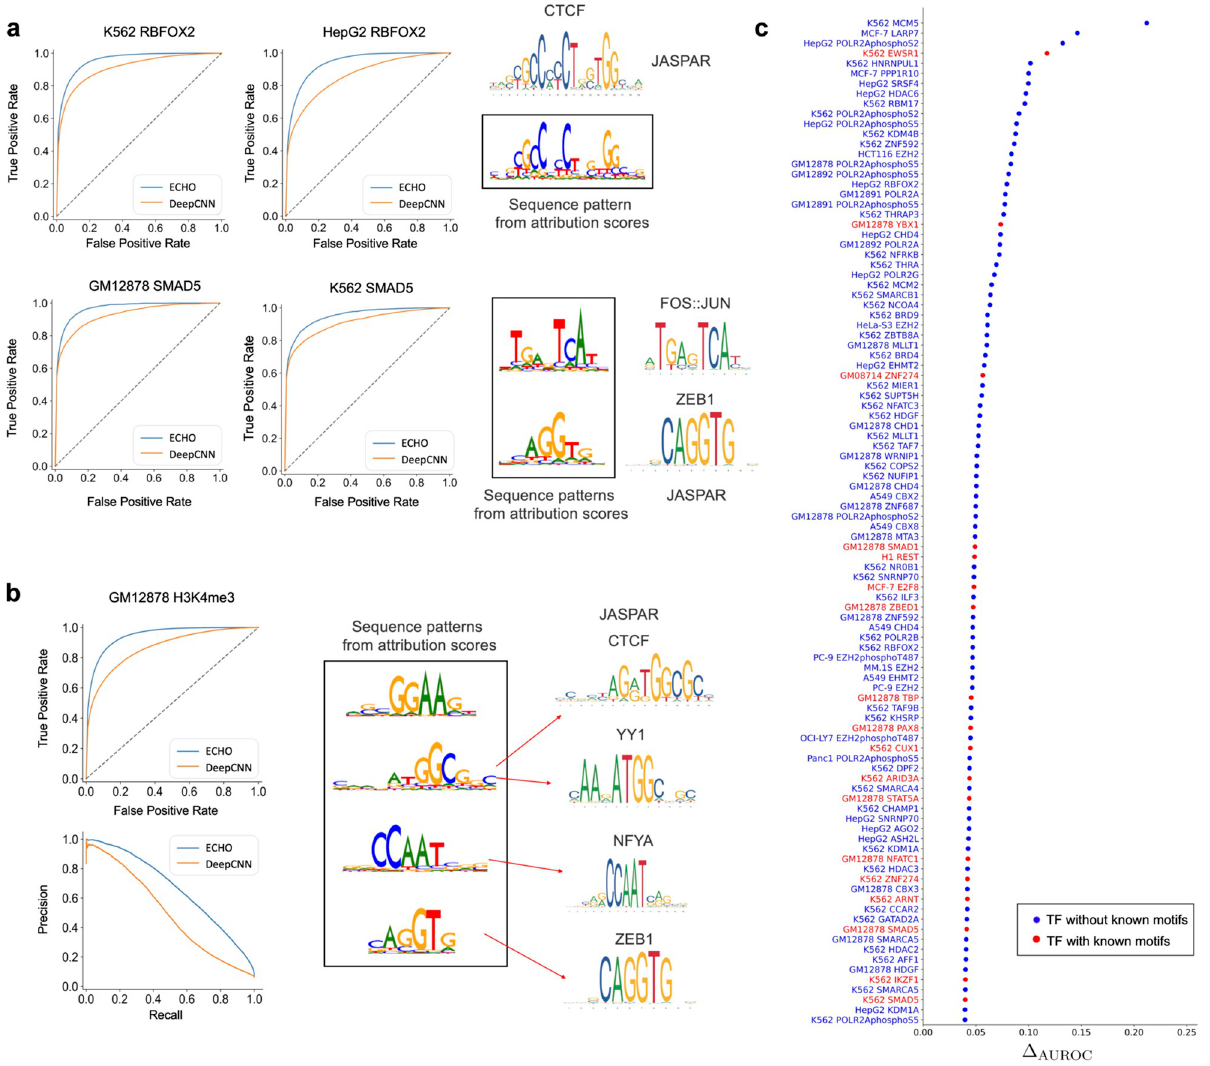
Fig 6. Model performance improvement compared to DeepCNN and visualization of sequence patterns in the neighborhood of investigated chromatin features. (a) ECHO predicts RBFOX2 and SMAD5 more accurately on all the collected cell lines than the baseline DeepCNN. The patterns generated by TF-MoDISco [25] using the selected neighbor sequences’ attribution scores for the corresponding TFs binding on central sequences, which are compared with known binding motifs from JASPAR [24]. (b) ECHO outperforms DeepCNN on GM12878 H3K4me3 prediction and the important patterns in the neighborhood are visualized. 400 neighbor sequences which have high attribution score contacts with successfully predicted GM12878 H3K4me3 sites are selected. The attribution scores of the neighbor sequences are input to TF-MoDISco to identify frequent patterns. Top four patterns are given, and some of them match several TFs’ binding motifs from JASPAR. (c) 100 TFs with the cell lines which achieve greatest improvement on AUROC compared to